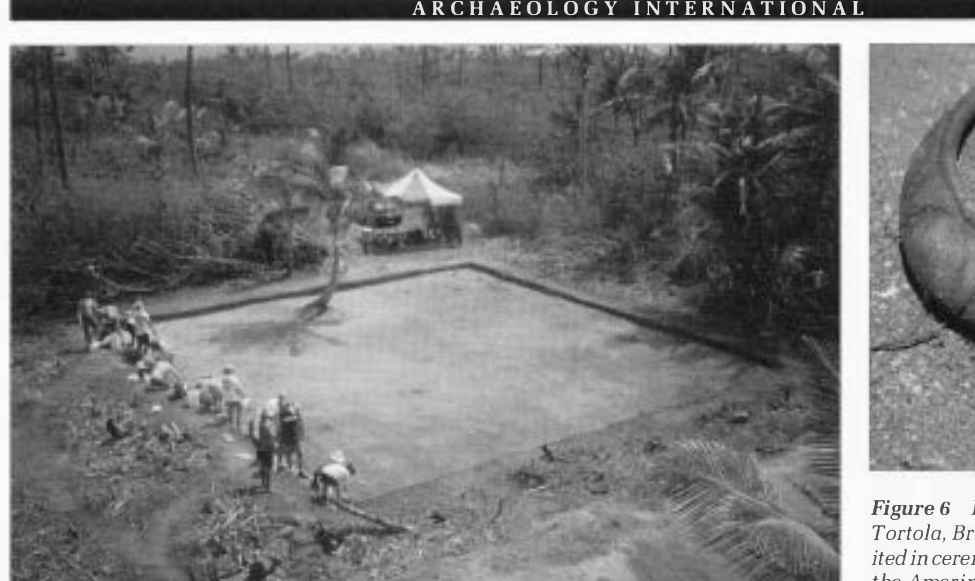
Figure 5 Belmont Archaeological Project, Tortola, British Virgin Islands. Area exca­ vation in 1997.